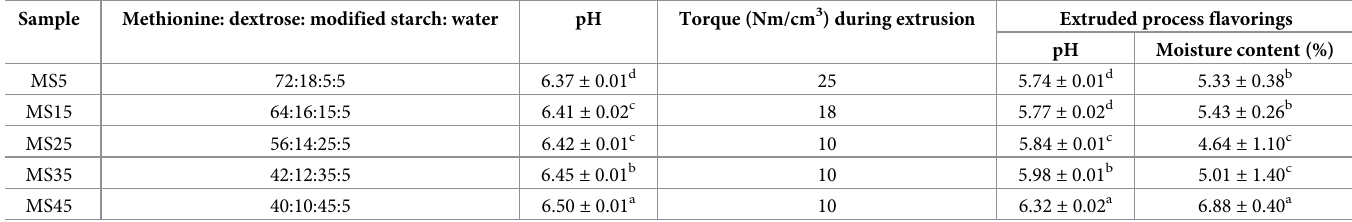
The barrel temperatures of zones 1, 2 were controlled at 100 and 120˚C with screw speed of 30 rpm. Means ± SD in the same column, followed by the same letter, are not significantly different at p <